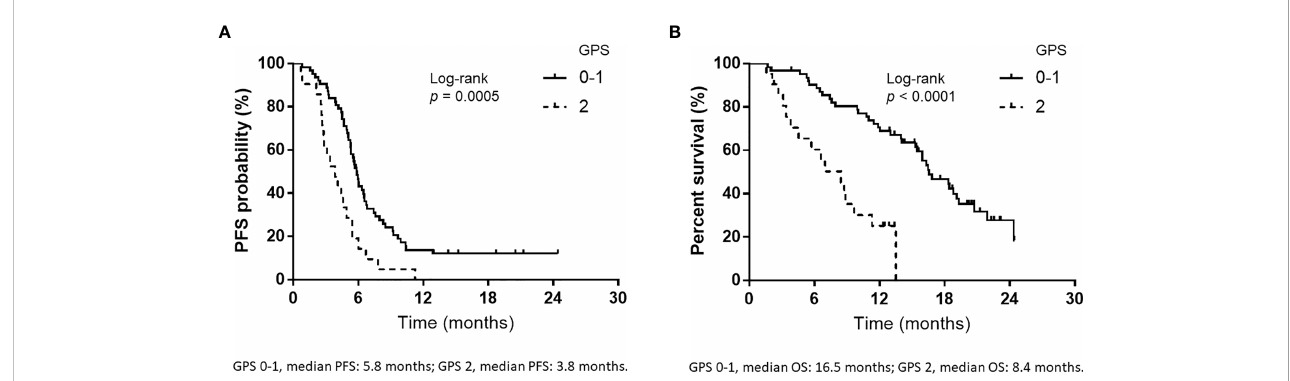
FIGURE 2 Kaplan – Meier curves for progression-free survival (PFS) and overall survival (OS) according to Glasgow prognostic score (GPS). (A) PFS according to GPS at the initiation of atezolizumab plus carboplatin and etoposide (GPS 0 – 1, median PFS: 5.8 months; GPS 2, median PFS: 3.8 months). (B) OS according to GPS at the start of atezolizumab plus carboplatin and etoposide (GPS 0 – 1, median OS: 16.5 months; GPS 2, median OS: 8.4